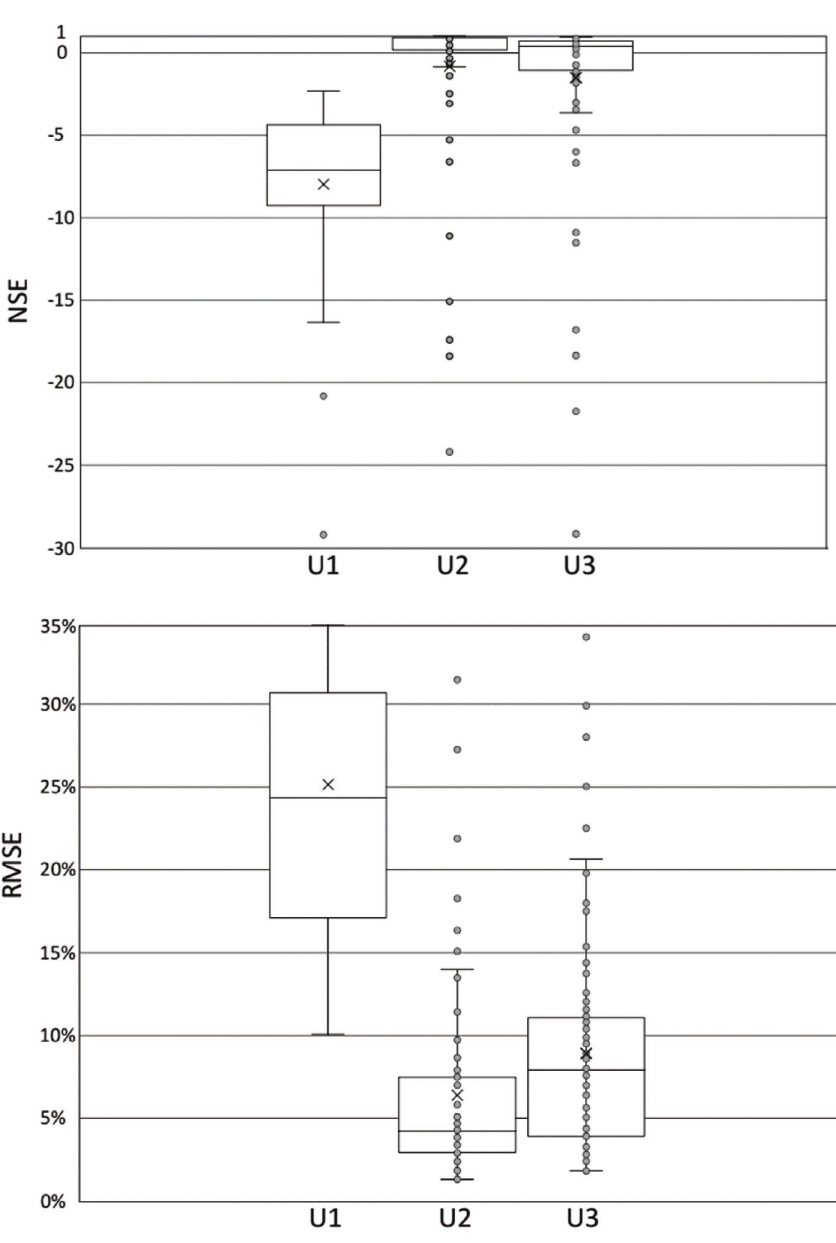
Figure 4. Performance of the entropy models according to the number of constraints. (a) Nash-Sutcliffe coefficient (NSE). (b) Root mean square error (RMSE). U1 encompasses the joint results for both U1y and U1ξ models. The same applies to U2 and